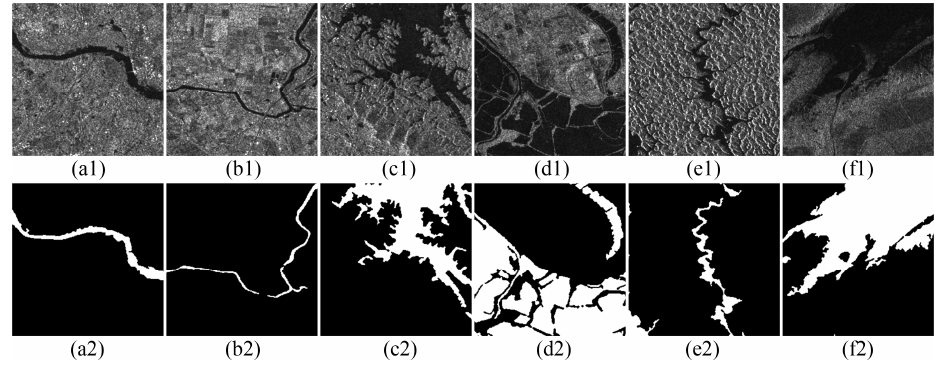
Figure 2. Example of sample patches. ( a1 – f1 ) SAR slices; ( a2 – f2 ) corresponding samples.